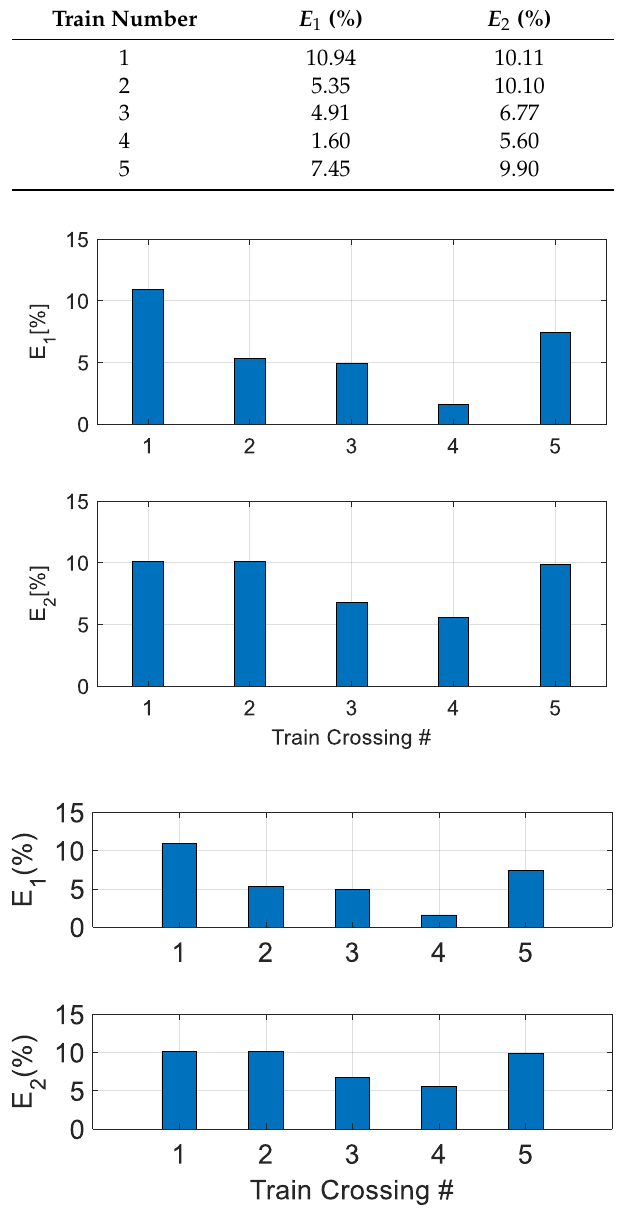
Figure 8. Performance evaluation results for total displacement estimation.